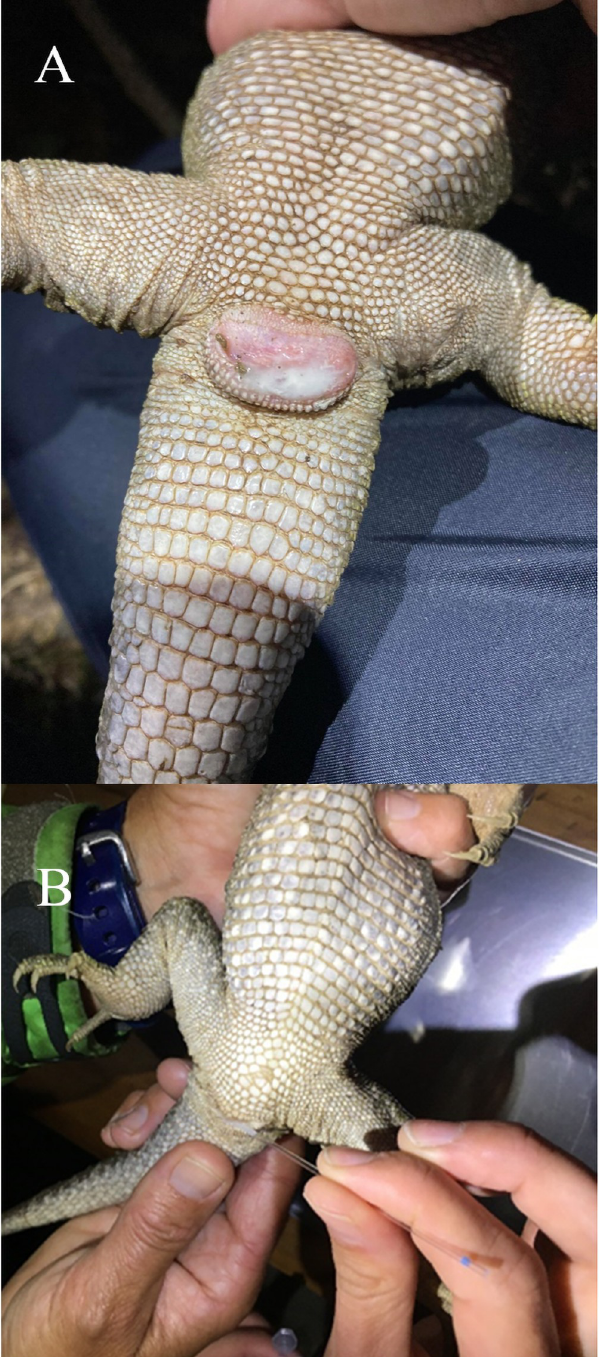
Fig 3. Sperm visible on a female’s cloaca after mating and collection. (A) Sperm is visible on the female’s cloaca after separating a mating pair. (B) Sperm being collected from the female’s cloaca with a microcapillary tube.